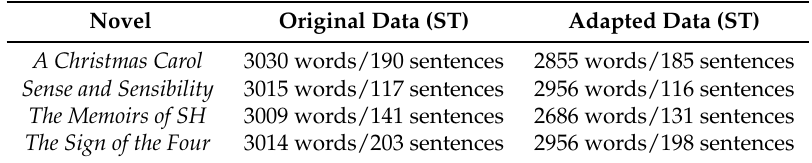
Table 1. Overview of data used for error analysis: Number of words and sentences in each novel before and after data was removed.